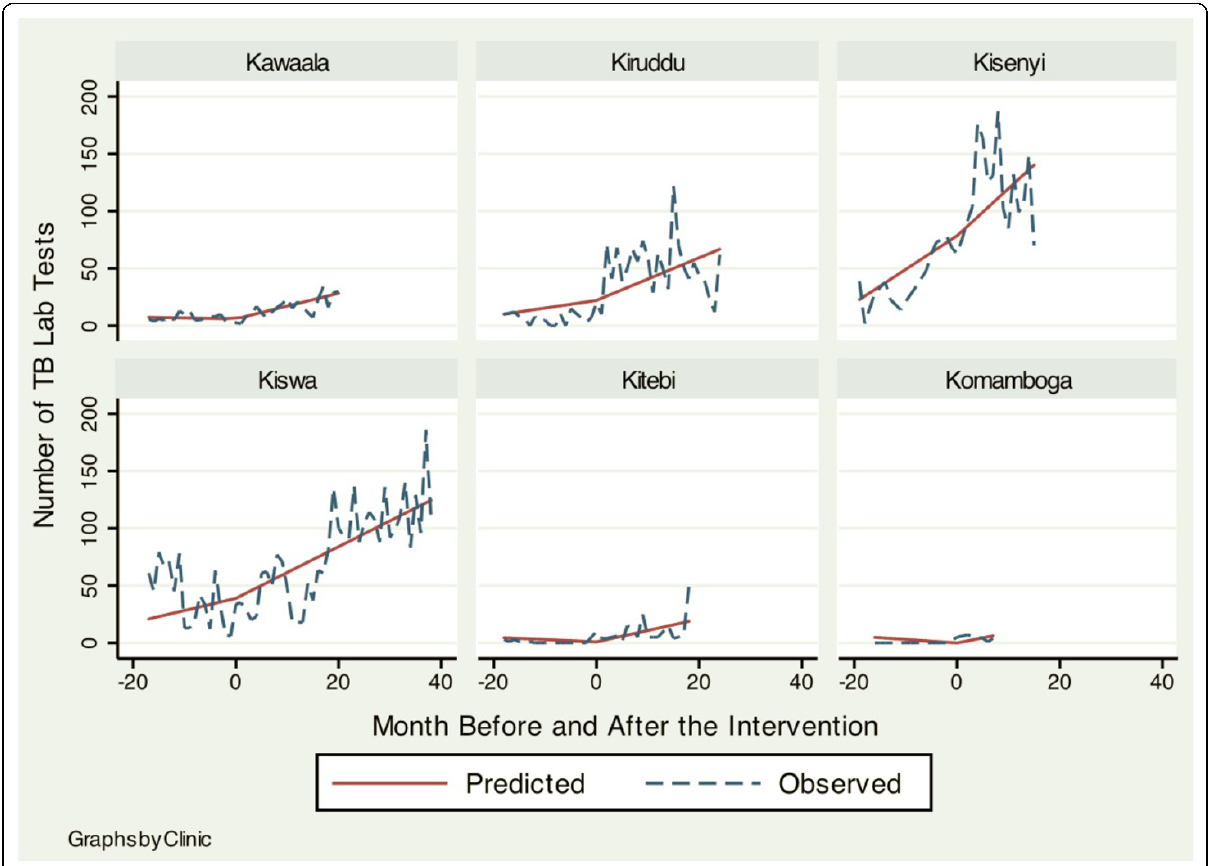
Figure 4 Fitted trends for key health services . Graphs by Clinic.